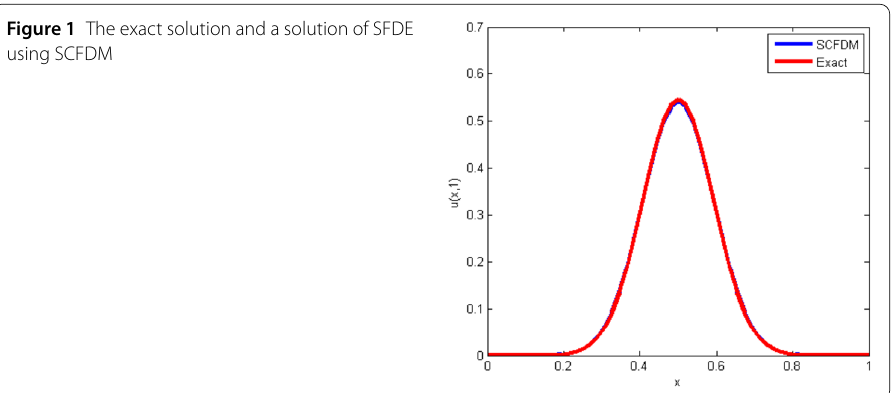
Figure 1 The exact solution and a solution of SFDE using